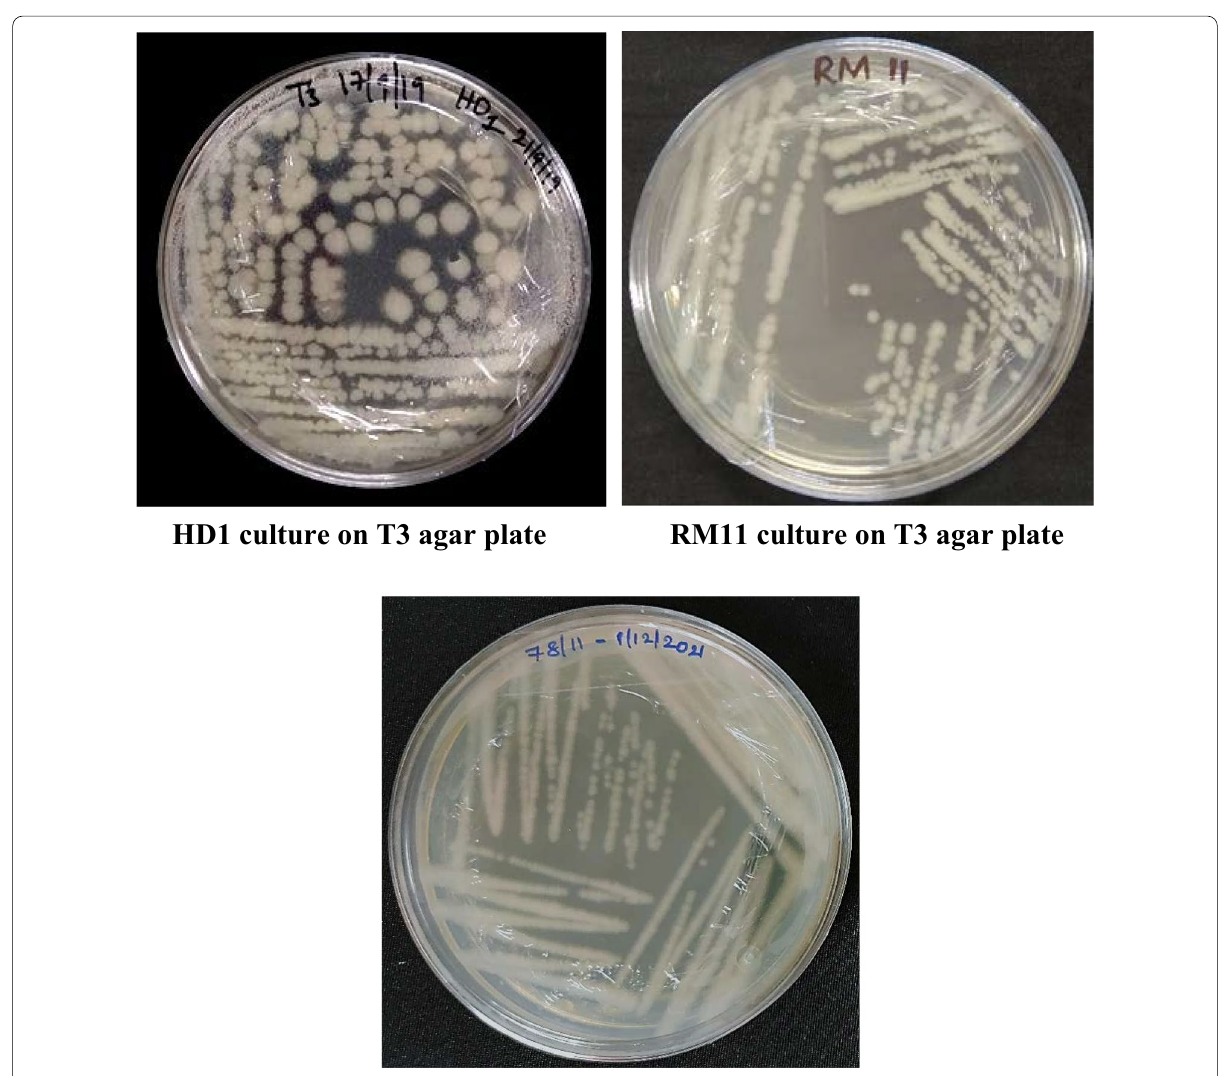
Fig. 1 Bacillus thuringiensis cultures on T3 agar